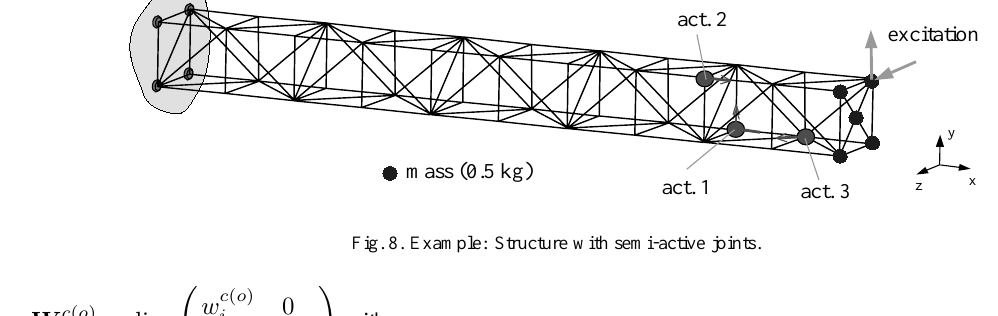
Fig. 8. Example: Structure with semi-active